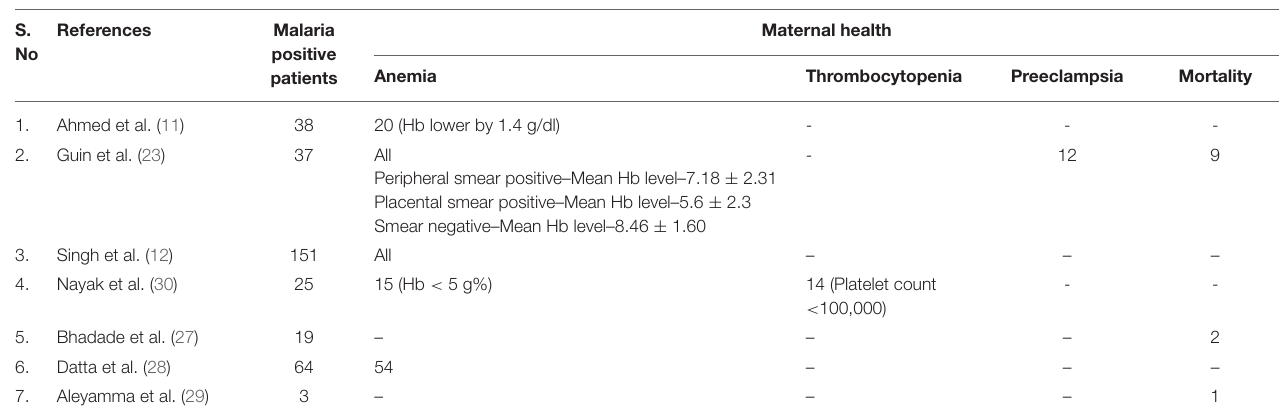
TABLE 3 | Effect of malaria on pregnant